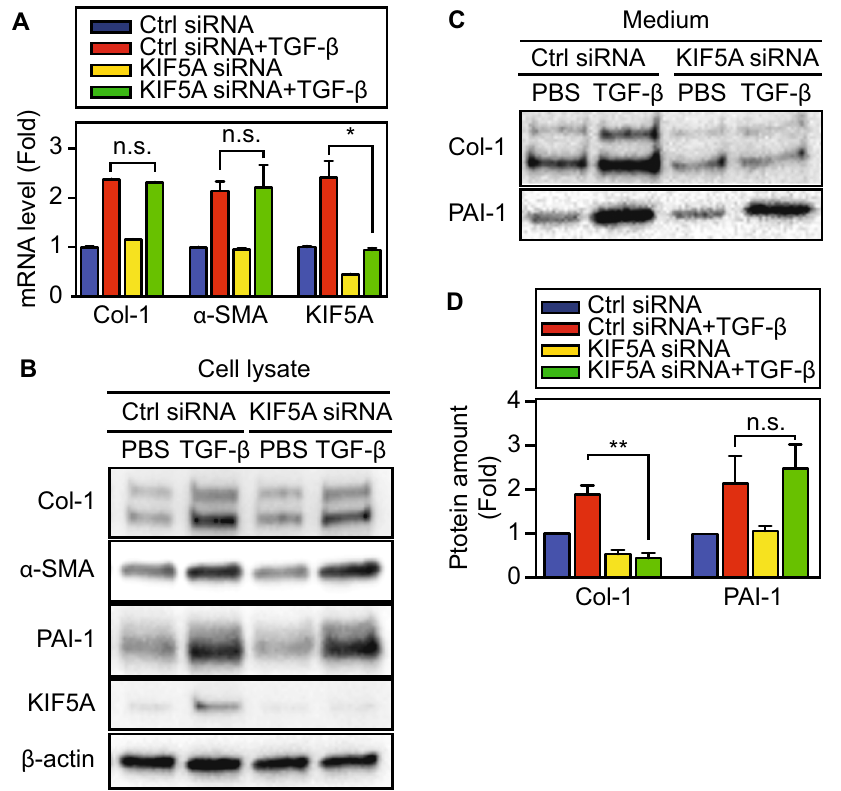
Figure 4. Effect of KIF5A KD on collagen secretion from HPMC. ( A ) Effect of KIF5A KD on mRNA level (n = 6). ( B , C ) Effect of KIF5A KD on protein amount in cell lysate ( B ) and in culture medium ( C ). Full-length blots were presented in Supplementary Figs S4 and S5. ( D ) Quantitative analysis using densitometry of western blotting of C (n = 3 for Col-1, n = 4 for PAI-1). * P < 0.05, ** P < 0.01 vs basal